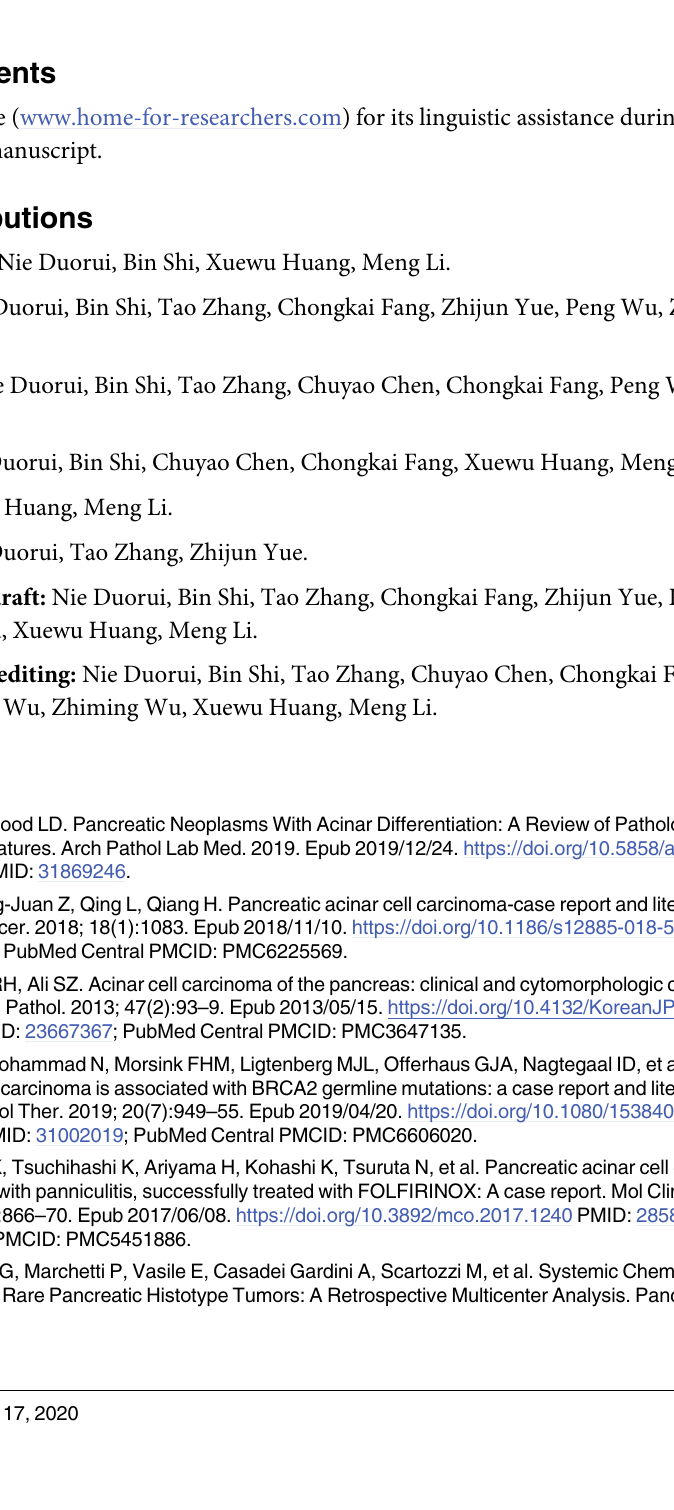
S2 Table. The clinical features of the patients with pancreatic acinar cell carcinoma accord- ing to stratification by the marital